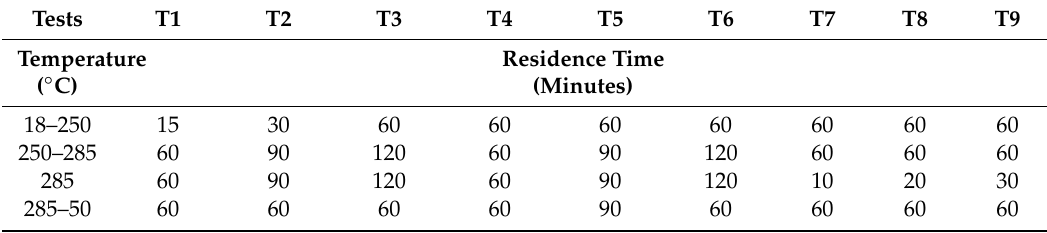
Table 2. Parameters applied to each series of